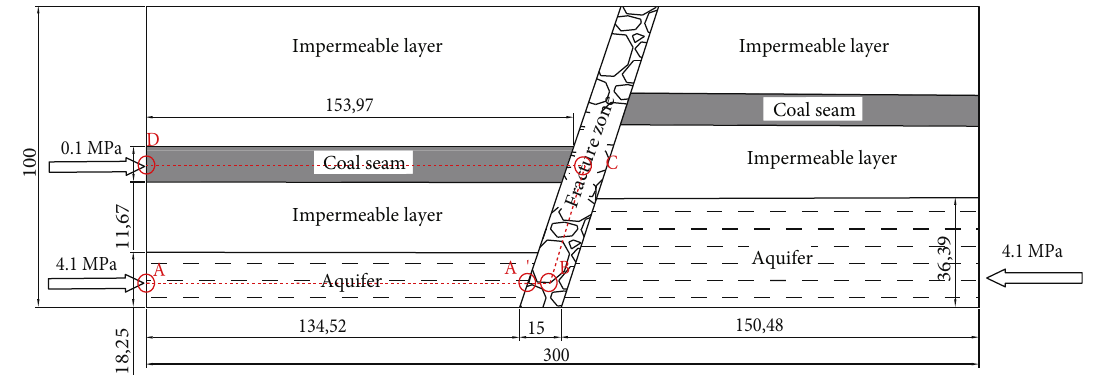
Figure 2: Numerical model of water inrush in Qiyue Mountain tunnel (unit :m). Table 1: The hydrodynamic parameters in three